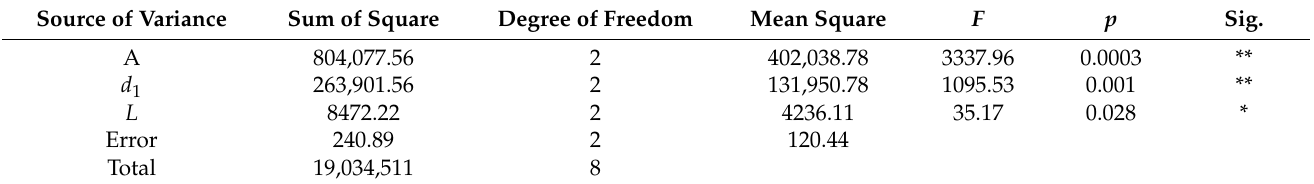
Table 5. Variance analysis of experiment